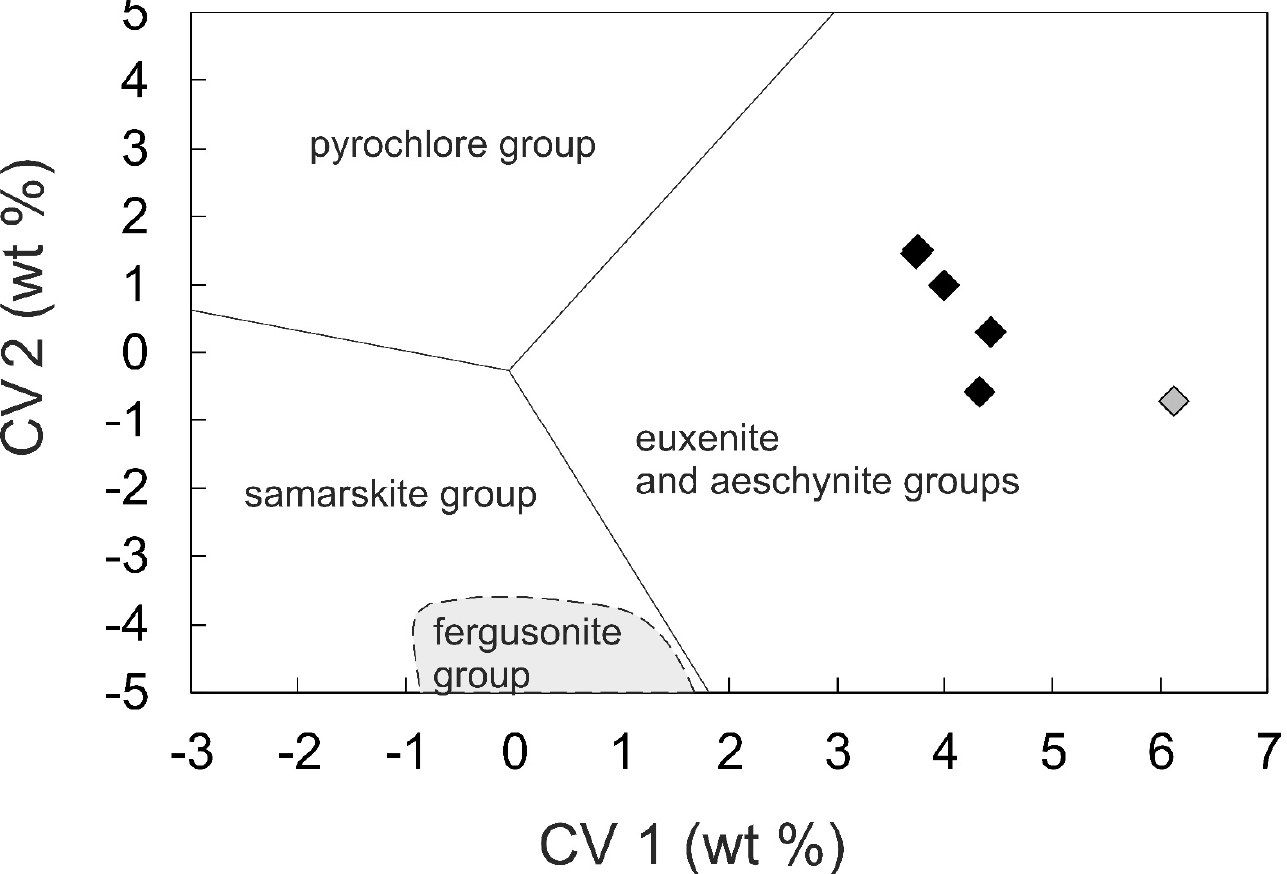
Figure 6. Aeschynite-(Y) plotted as canonical variables CV1 and CV2 of the three-group model of Ercit (2005). Data are from Table 3. CV1 = 0.245 Na + 0.106 Na + 0.106 Ca − 0.077 Fe* + 0.425 Pb + 0.220 Y + 0.280 LREE + 0.137 HREE + 0.100 U* + 0.304 Ti + 0.097 Nb + 0.109 Ta* − 12.81 (oxide wt%). CV2 = 0.102 Na − 0.113 Ca − 0.371 Fe* − 0.167 Pb − 0.395 Y − 0.280 LREE − 0.265 HREE − 0.182 U* − 0.085 Ti − 0.166 Nb − 0.146 Ta* + 17.29 (wt%). Fe* = Fe + Mn; U* = U + Th; Ta* = Ta+W.